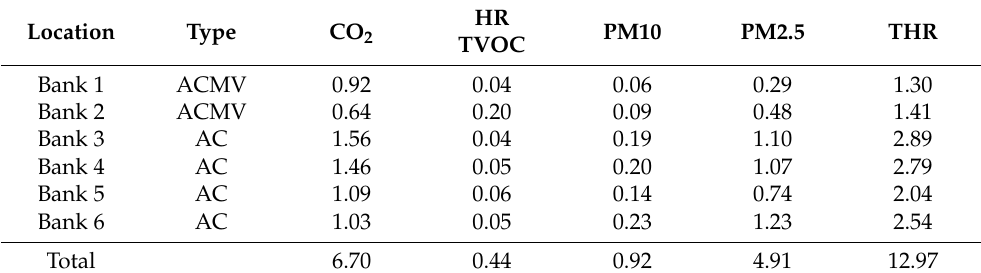
Table 6. Hazard ratio in the bank vault.